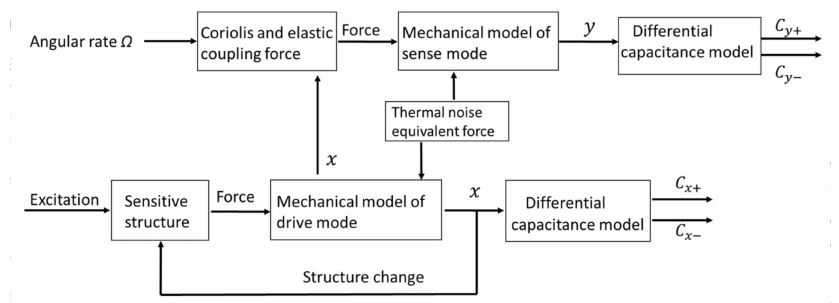
Figure 2. The principle diagram of capacitive microelectromechanical systems (MEMS)